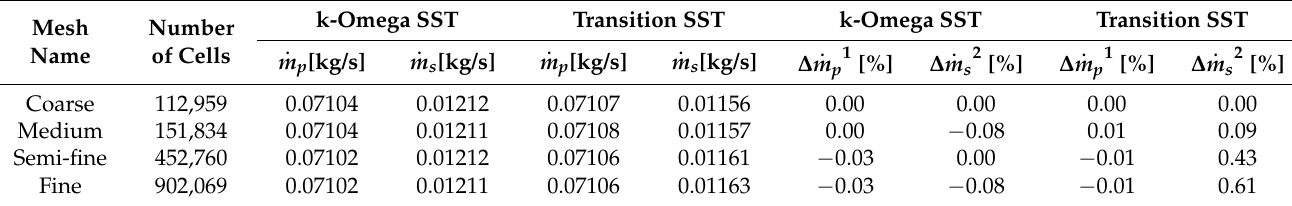
Table 2. The comparison of mass flow rates change with mesh size